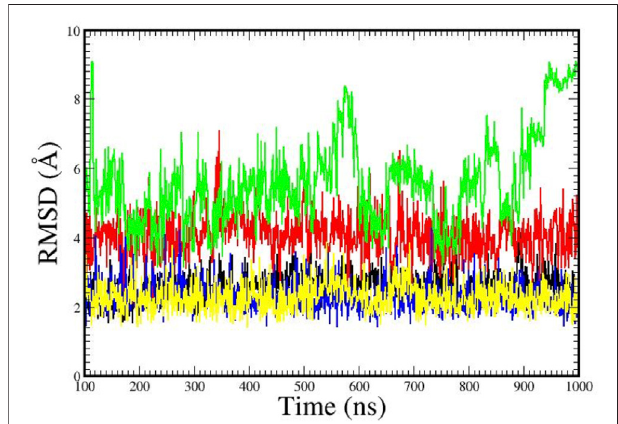
FIGURE 3 | Root mean squared deviations (RMSDs) in the structures over the 1 µs time of the MD simulation trajectory. Legend: Adduct-free DNA (black);DNAwiththeaminobiphenyladduct(green);DNAwiththeazobiphenyl adduct (red); DNA with the Sudan I dye adduct (yellow); DNA with the Sudan II dye adduct